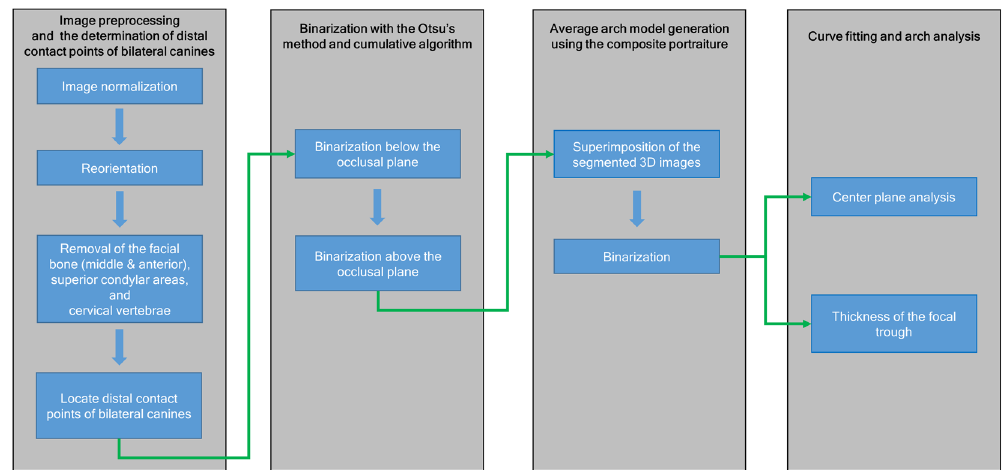
Figure 1. Flowchart of image processing and analysis. After image preprocessing and determination of the distal contact points of the bilateral canines, binarization and average arch shape generation were performed. The center, boundaries, and minimum thickness of the focal trough were then